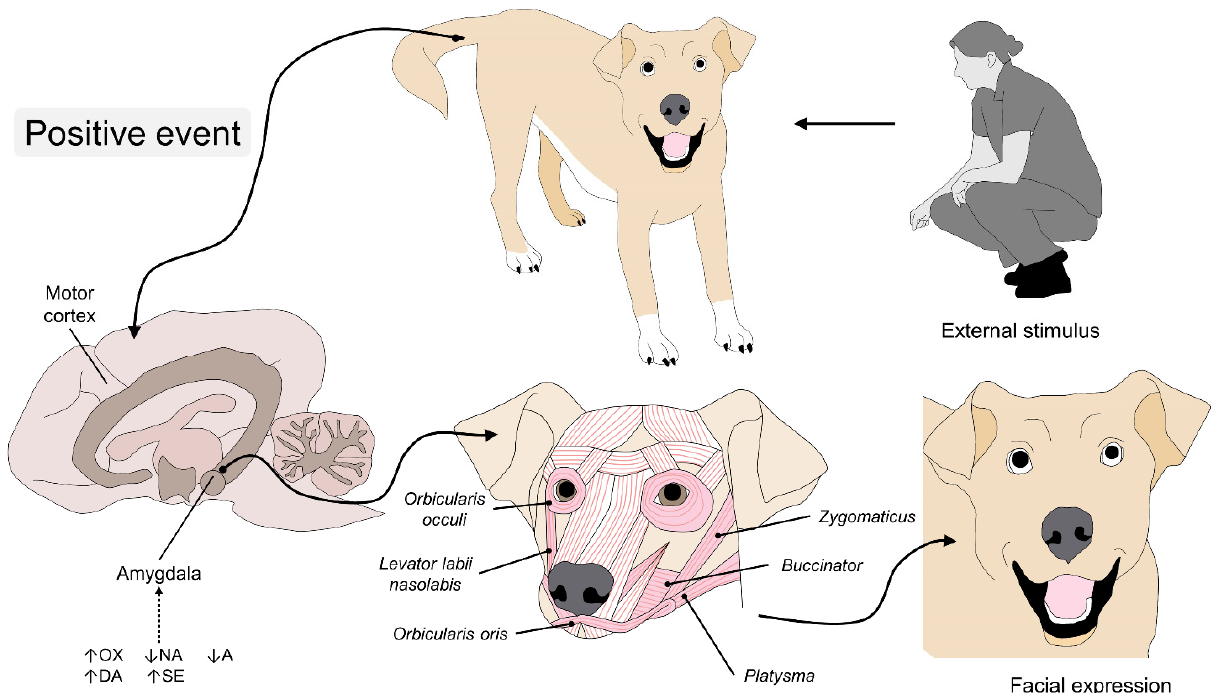
Figure 4. Endocrine and motor control of facial expression during pleasant emotions in canines. When the amygdala associates the presence of humans or conspecifics to a positive emotion, the levels of OXT, DA, and SE increase in response to the stimulus; this activates the facial units that enlarge the eyes and retract the muscles of the mouth to produce a simulated “smile”. OX: oxytocin; NA: noradrenaline; A: adrenaline; DA: dopamine; SE: serotonin.